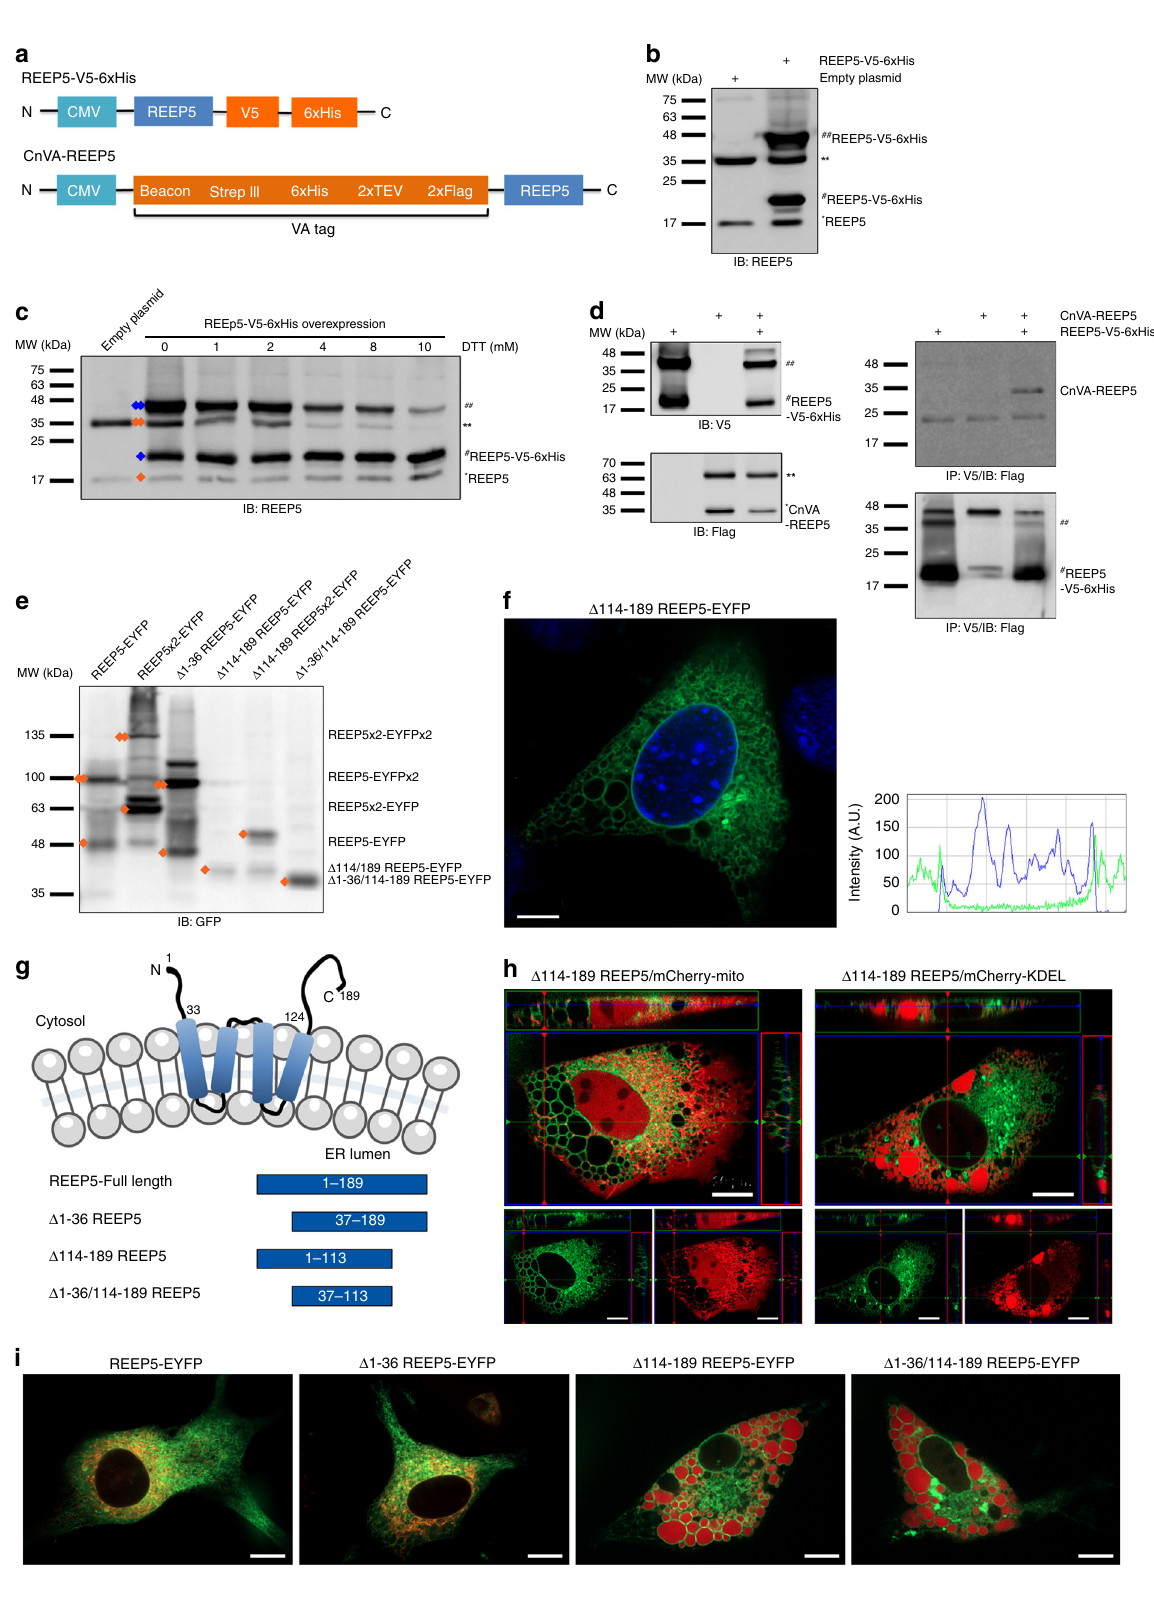
(133 ± 5 bpm in control vs. 125 ± 4 bpm in reep5 CRISPR fi sh model 41 . Zebra fi sh at 48 hpf were treated with 0.6 mg/mL under resting conditions, compared to 131 ± 4 bpm in control vs. verapamil for 30 min to induce a rapid decrease in heart 99 ± 4 bpm in the reep5 CRISPR fi sh with verapamil treatment; rate and contractility, ultimately leading to heart failure 41 . The p = 0.003. Data presented as mean ± SEM (Fig. 8f). Compensa- reep5 germline mutants treated with verapamil displayed tory network induced by deleterious mutations in CRIPSR sensitized cardiac dysfunctional phenotypes highlighted by a germline mutants, but not in zebra fi sh knockdown models such marked reduction in heart rate compared to control embryos NATURE COMMUNICATIONS| (2020) 11:965